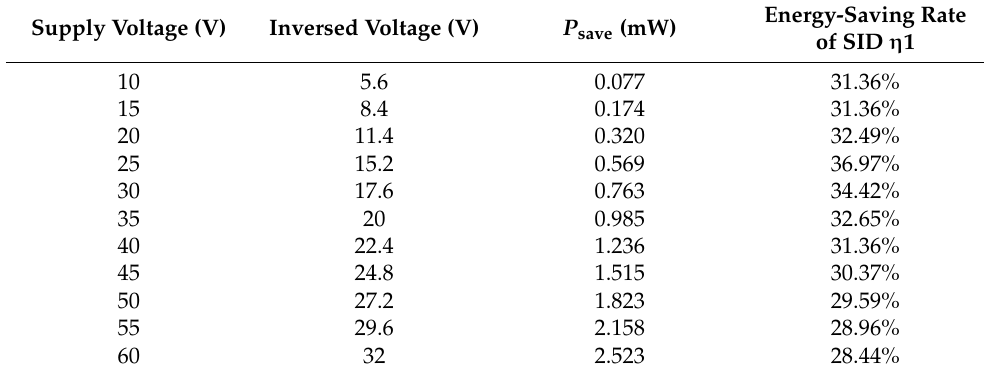
Table 3. Power and energy-saving rate at different voltages of SID circuit.